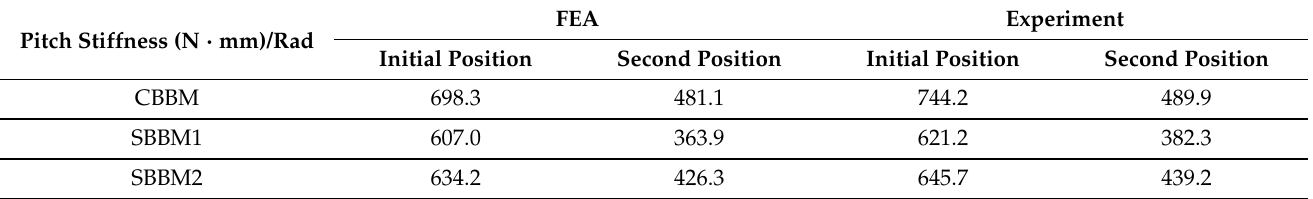
Table 2. Comparison between simulation and experimental results of pitch stiffness in different